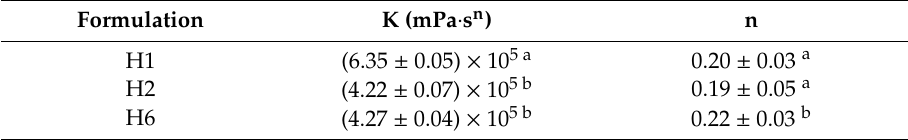
Table 5. Power-law fit parameters obtained from the linear regression of the log-log plot at low shear rate for the di ff erent bigel samples. Parameters were fitted using three